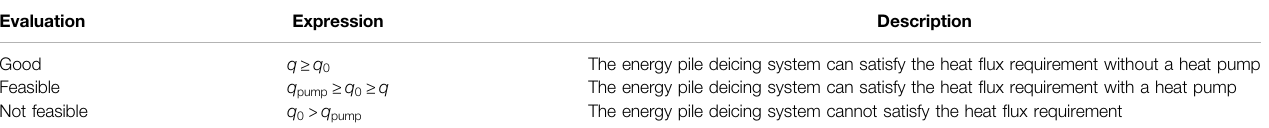
TABLE 1 | The evaluation of the energy pile deicing system for bridge deck. Evaluation